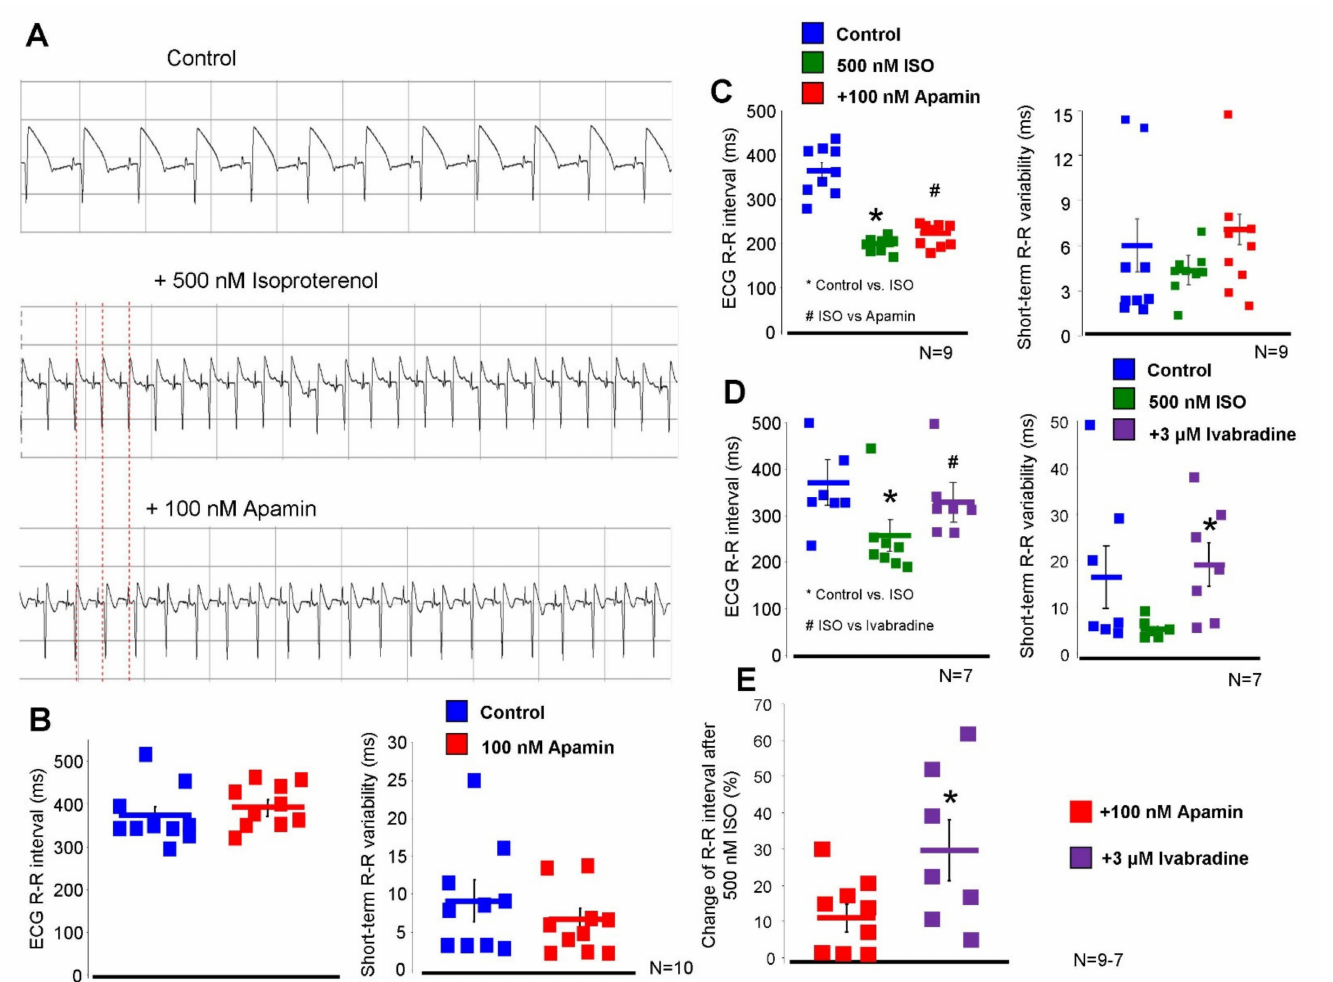
Figure 7. Results of Langendorff-perfused experiments on isolated hearts. ( A ) demonstrates original ECG traces in control condition (upper panel), in the presence of 200 nM isoproterenol (middle panel), and after apamin application (lower panel). Red vertical dashed lines indicate the change of the cycle lengths. ( B ) represents the basal condition (i.e., without application of isoproterenol). The ECG R-R interval (left graph) and the R-R variability (right graph) were unaltered after apamin administration. ( C ) represents apamin application in the presence of 500 nM isoproterenol. 100 nM apamin increased the ECG R-R interval (left graph), however, it did not change the R-R variability (right graph). ( D ) illustrates the effect of 3 µ M ivabradine. Ivabradine markedly increases the R-R interval (left graph) and the R-R interval variability (right graph). ( E ) shows the comparison of the effects of apamin and ivabradine on the ECG R-R interval after 200 nM isoproterenol. Statistical analysis was performed by paired t -test and repeated measures ANOVA ( p <